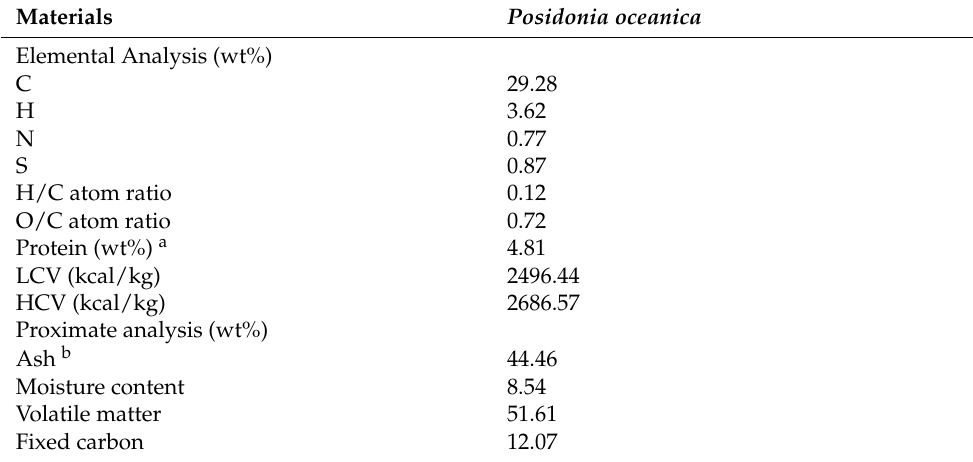
Table 1. Physicochemical characterization of the Posidonia oceanica wastes (unwashed).